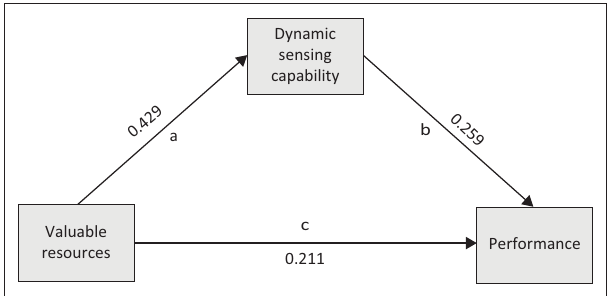
FIGURE 2: Unstandardised path